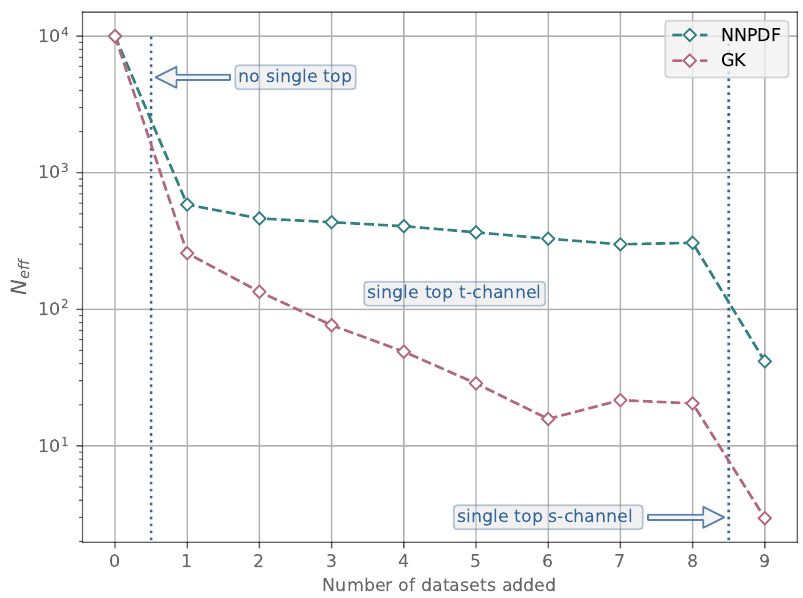
Figure 4.2: Same as Fig. 3.2, now comparing the effective number of replicas N addition of new data using either the NNPDF or the GK weights. In both cases, the prior is = 10 4 the same and it is made of N rep